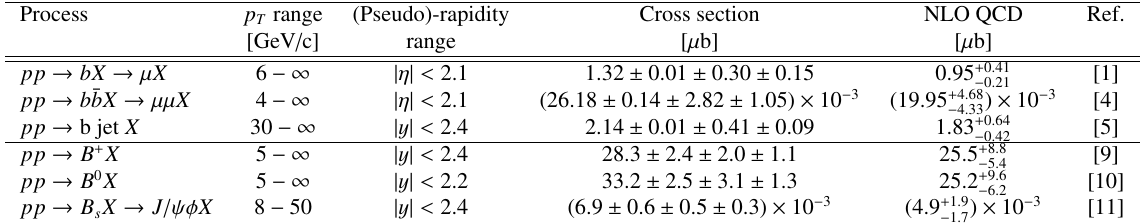
Table 1. Summary of measured b-quark cross sections in inclusive (top) and exclusive (bottom) channels and comparison with NLO QCD expectations. The experimental uncertainties indicate (from left to right) the statistical, systematic and luminosity. Theoretical uncertainties are obtained from scale variations.